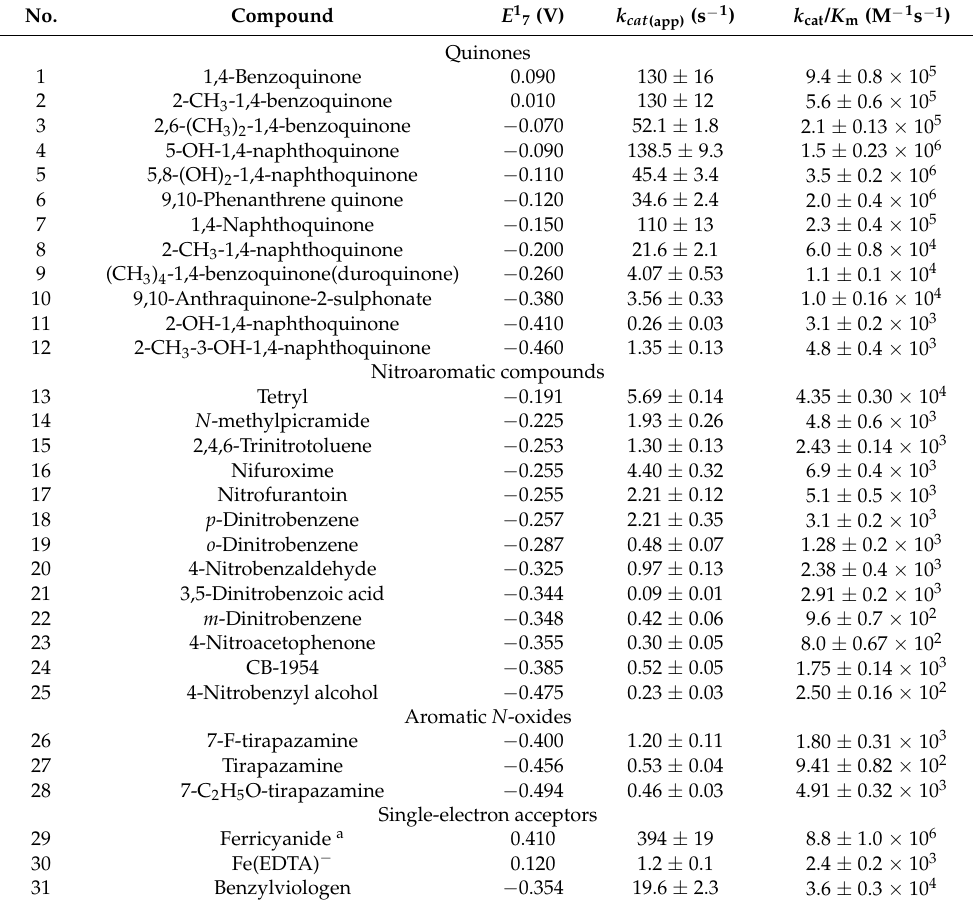
Table 1. Steady-state rate constants of the reduction of nonphysiological electron acceptors by 100 µ M NADPH catalyzed by Rp FNR. The E 1 7 values of compounds taken from [22,28,29]. No.